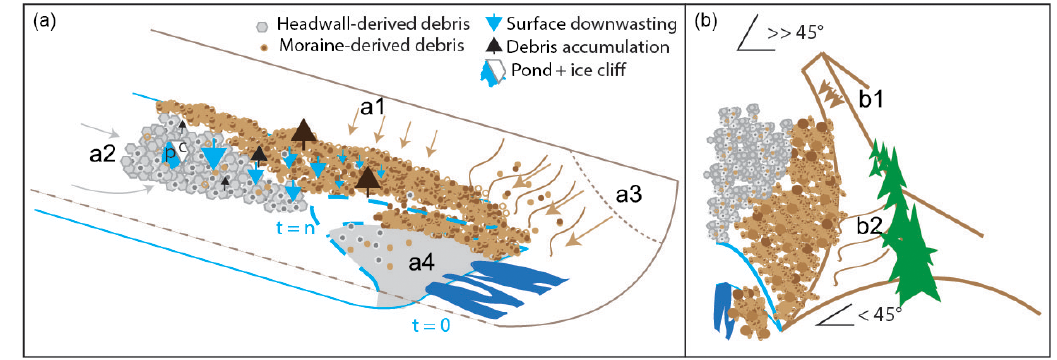
Figure 11. Dominant processes at lateral moraines and consequences for the glacier terminus of a debris-covered glacier. Mass transport from lateral moraines (a1) as well as debris transport from head walls and englacial transport (a2) are shown. Slumping as a consequence of debuttressing at the terminus (a3) brings more material into the glacier forefield (a4) , as the tongue retreats in time ( t ). As a consequence, the moraine crest slumps (b2) and the moraine becomes shallower compared to upper parts where transport is mainly to rockfall and debris flows (b1)